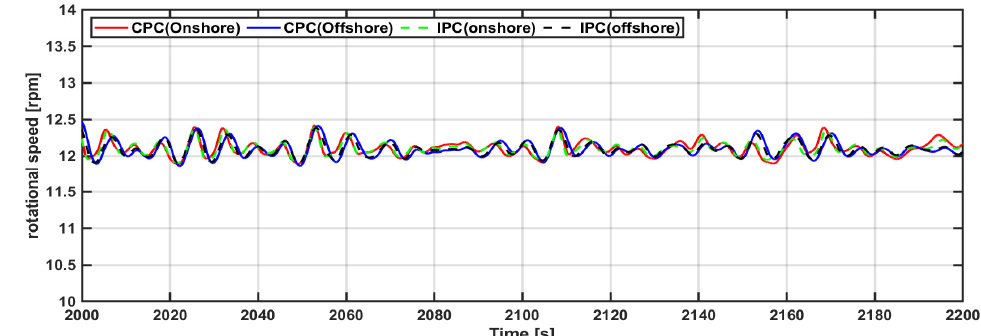
Figure 8. Rotor rotation speed of floating offshore wind turbine based on pitch controller.